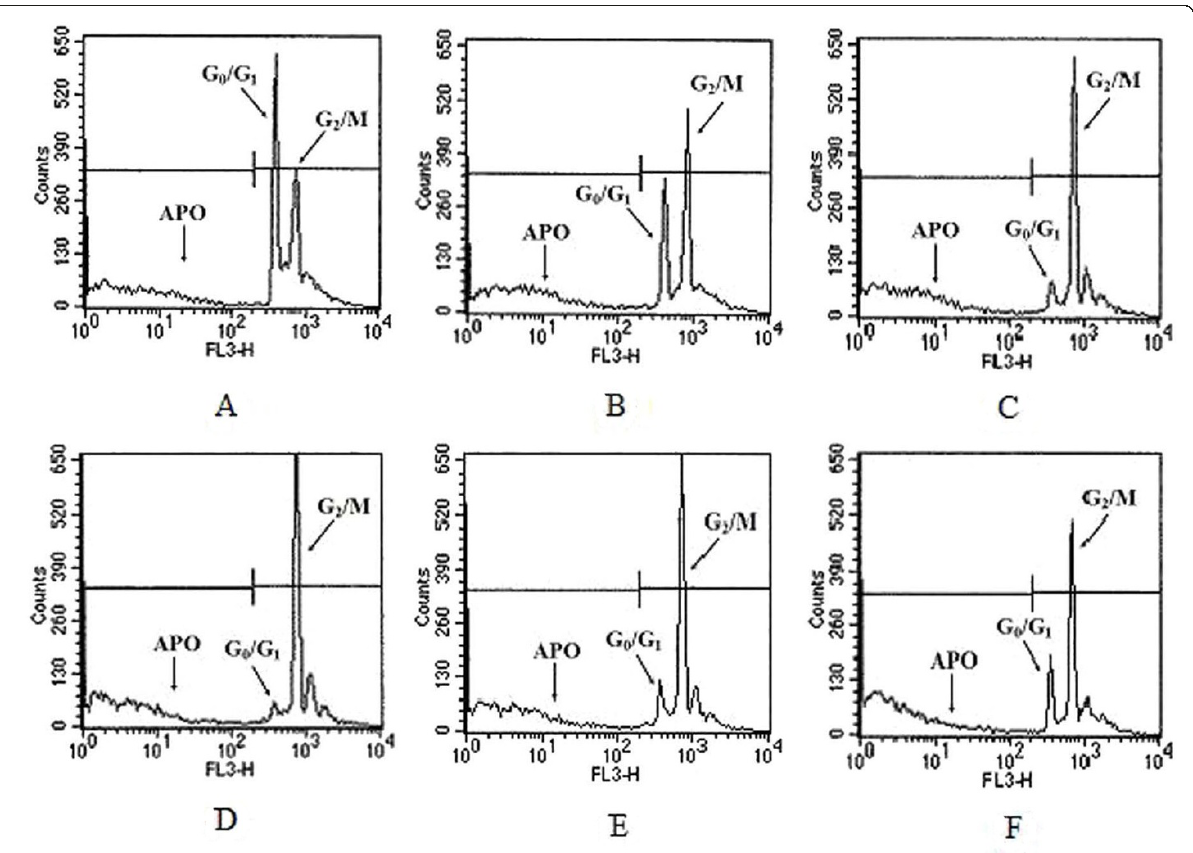
Figure 4 TC extract induced apoptosis in a dose-dependent manner and arrested the cell cycle at G 2 /M . The sub-DNA apoptotic peak, G 0 /G 1 peak, and G 2 /M peak were quantified by flow cytometry after treatment of PC-3M-1E8 cells for 24 h with the following concentrations of TC extract: 0 μ g/ml as a control (A), 1.67 μ g/ml (B), 4.16 μ g/ml (C), 8.33 μ g/ml (D), 33.33 μ g/ml (E), and 66.67 μ g/ml (F). The cells were stained with propidium iodide and analysed by flow cytometry.